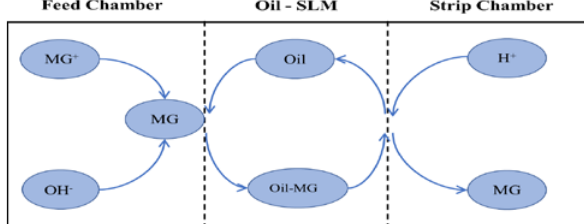
Figure 8. The mechanism of supported liquid membrane transport.